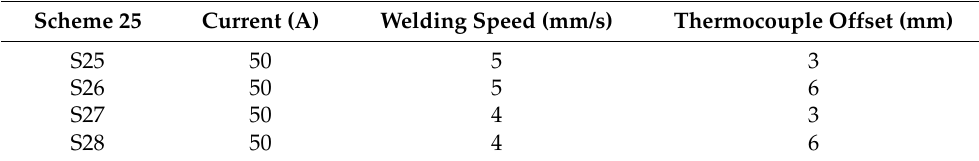
Figure 3. The reflected temperature correction map. Table 2. Parameters of the welding processes selected for making sample joints.